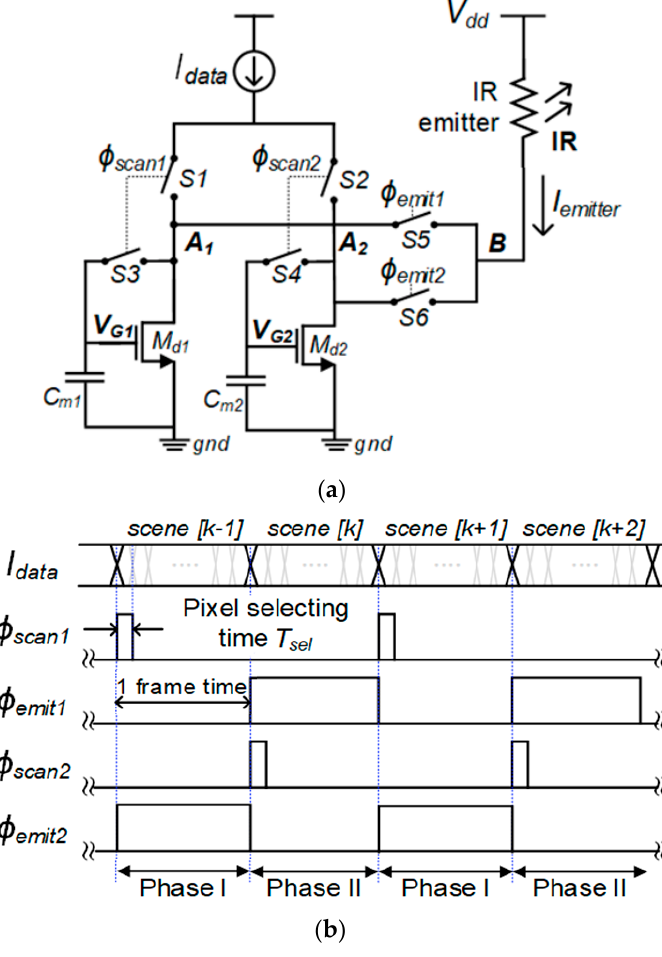
Figure 3. ( a ) Proposed RIIC unit pixel diagram; ( b ) corresponding timing diagram.